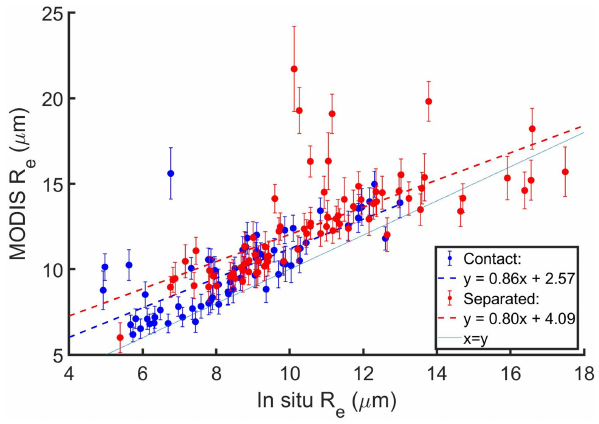
Figure 15. Same as Fig. 8a but with cloud profiles colored based on regime classification.